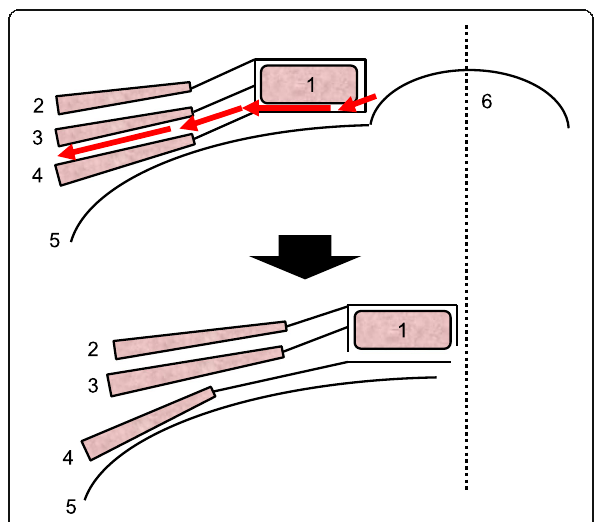
Fig. 4 Schema of the posterior components separation technique applied for the present case. Arrows indicate directions of incision. A dashed line shows midline. 1 Rectus abdominis muscle, 2 external oblique muscle, 3 internal oblique muscle, 4 transversus abdominis muscle, 5 transversalis fascia and peritoneum, and 6 hernia sac